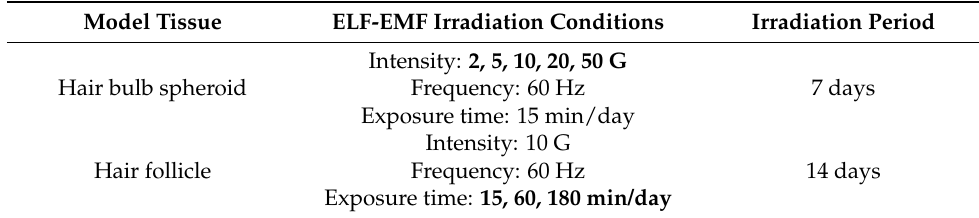
Table 1. Summary of the experimental